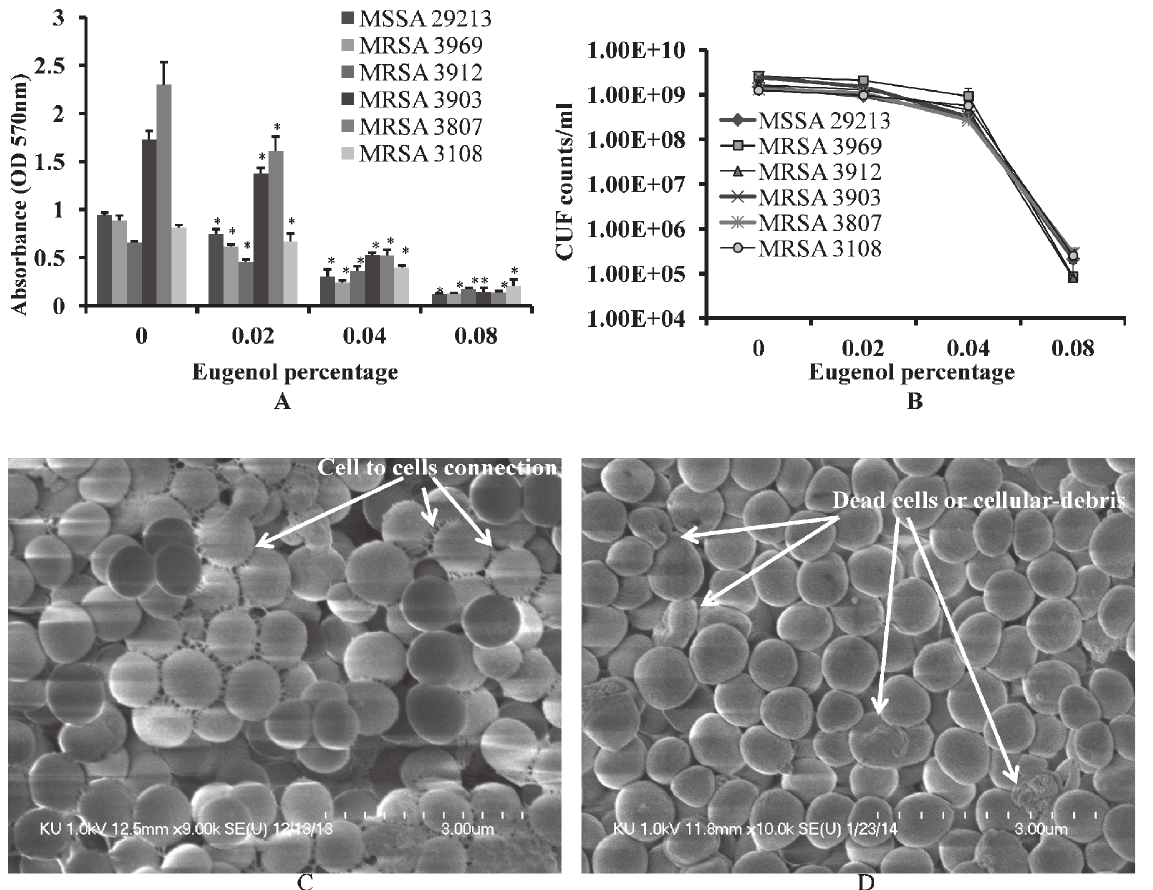
Fig 3. Eradication of established biofilms of MRSA and MSSA by a range of concentrations of eugenol. (A) Decreased biomasses of established biofilms, detected by microtiter plate assay. (B) Decreased cell viability of biofilm, detected by cfu counts. The error bars represent standard deviation from the mean value. (C) Representative SEM image of established untreated biofilm of S . aureus (29213). (D) Representative SEM image of established biofilm treated with eugenol (MIC). SEM images scale bar corresponds to 3 μ m.